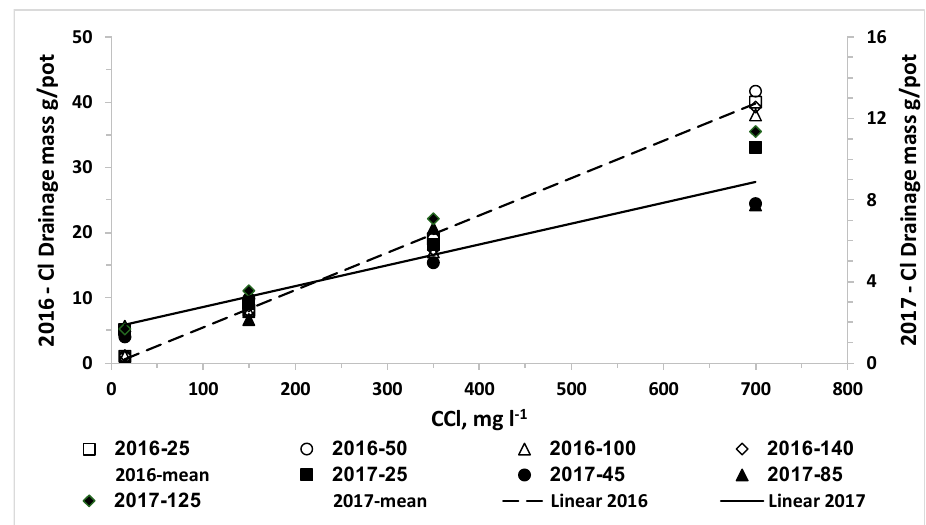
Figure 4. Cl mass in the leachate of lettuce experiments, 2016 and 2017. The equations of best fit curves presented in Figure 4 are as follows: 2016, Y = 0.057X − 0.2646, R 2 = 0.998. 2017, Y = 0.010X + 1.73, R 2 =